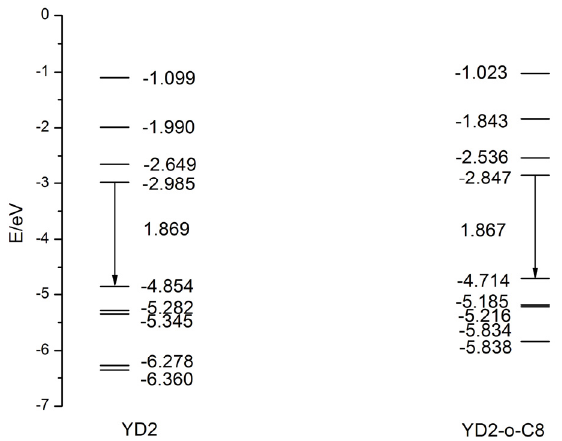
Figure 3. The calculated frontier molecular orbitals energies and HOMO-LUMO gap at the HSE06/6-31G (d,p) level in THF